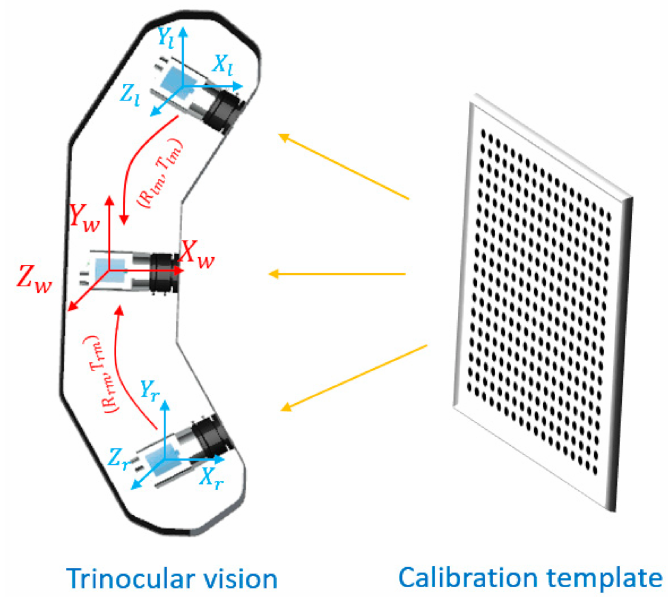
Figure 3. Calibration of